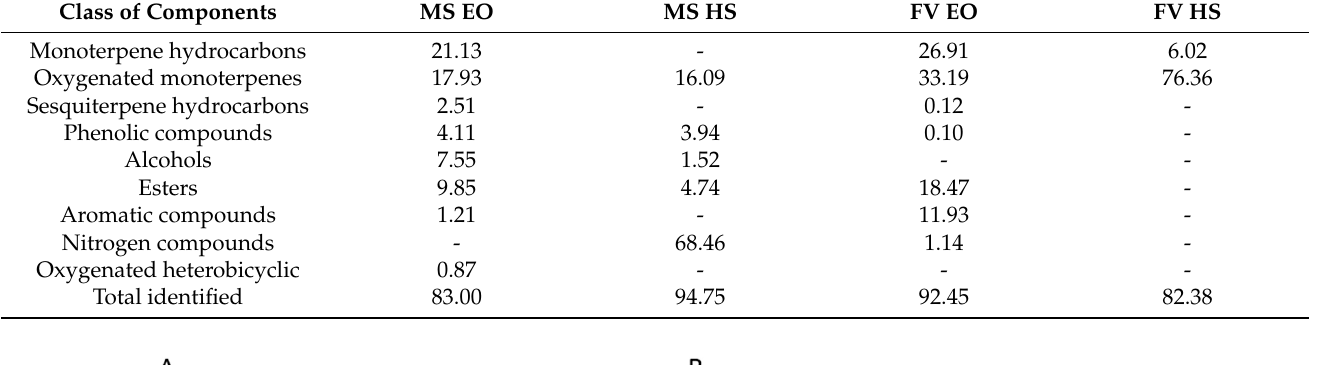
Table 1. Summary of chemical classes retrieved in EOs and HSs used in this study expressed as percentage of the total ion current (TIC) as measured using GC-MS. Values are expressed as means of three chromatographic replicate runs. MS EO = M. suaveolens essential oil; MS HS = M. suaveolens hydrosol; FV EO = F. vulgare essential oil; FV HS = F. vulgare hydrosol.